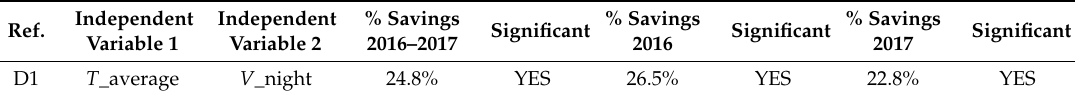
Table 14. Multiple regression